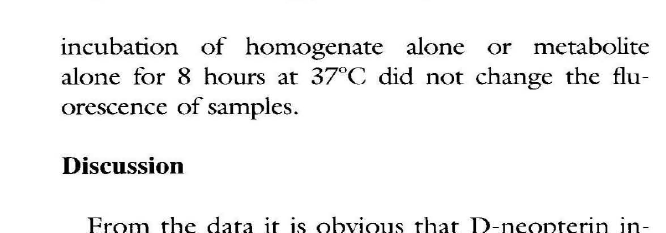
Figure 8. Concentrations (mean±S.D.) of cholesterol and phospholipids, as well as fatty acid content (in percent: mean±S.D.) in controls (open bars) and in samples with 5 pmoljg wet weight xanthopterin (dotted bars) and 30 pmol/ g wet weight xanthopterin (hatched bars). Samples of rat liver tissue homogenates were used to test tor phos pholipid biosynthesis in vitro. Incubation medium: Krebs-Ringer-phosphate buffer, containing 0.3% albumin (pH=7.4), fatty acid mixture and glycerol. Samples were incubated twice for 4 h at 37"C